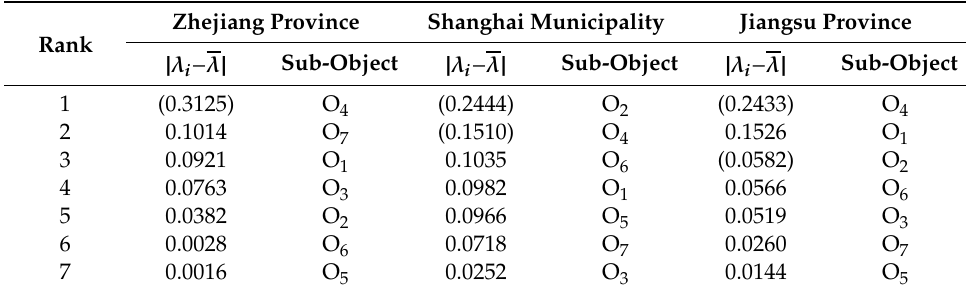
Table 3. The ranks of the weakened EEQ sub-objects in the YRD region. Zhejiang Province Shanghai Municipality Jiangsu Rank